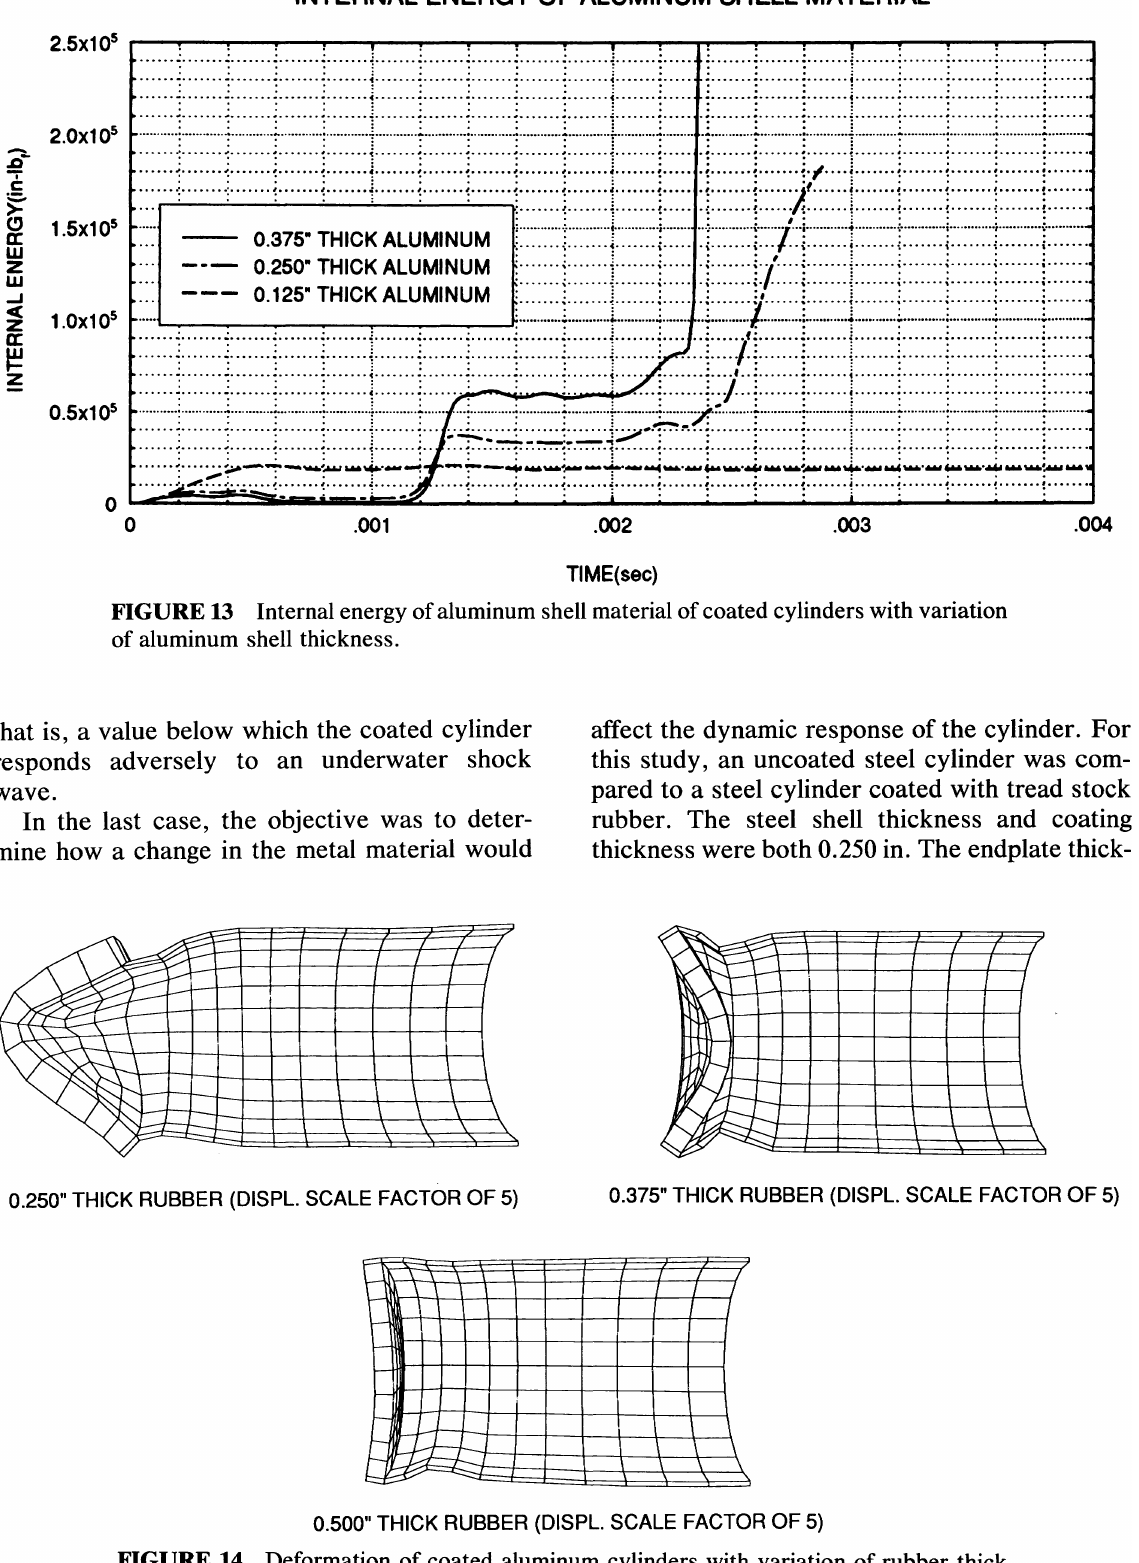
FIGURE 14 Deformation of coated aluminum cylinders with variation of rubber thick ness at 2.86